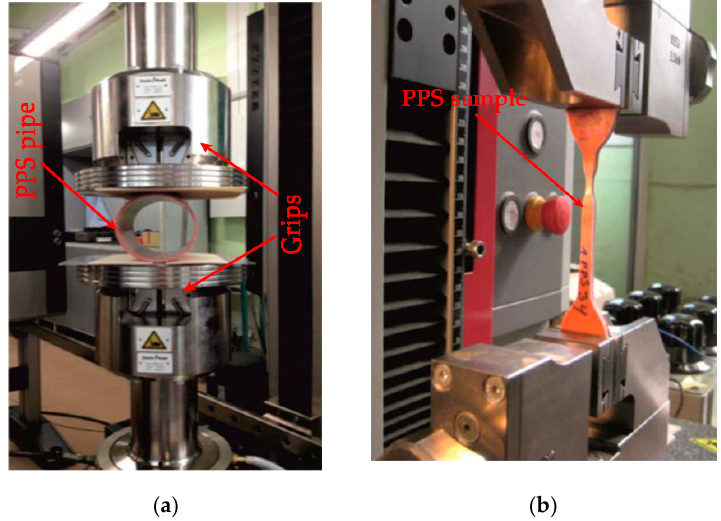
Figure 3. Testing of specimens: ( a ) initial stage of testing the ring stiffness and flexibility of a PPS sample; ( b ) tensile testing of a PPS specimen.